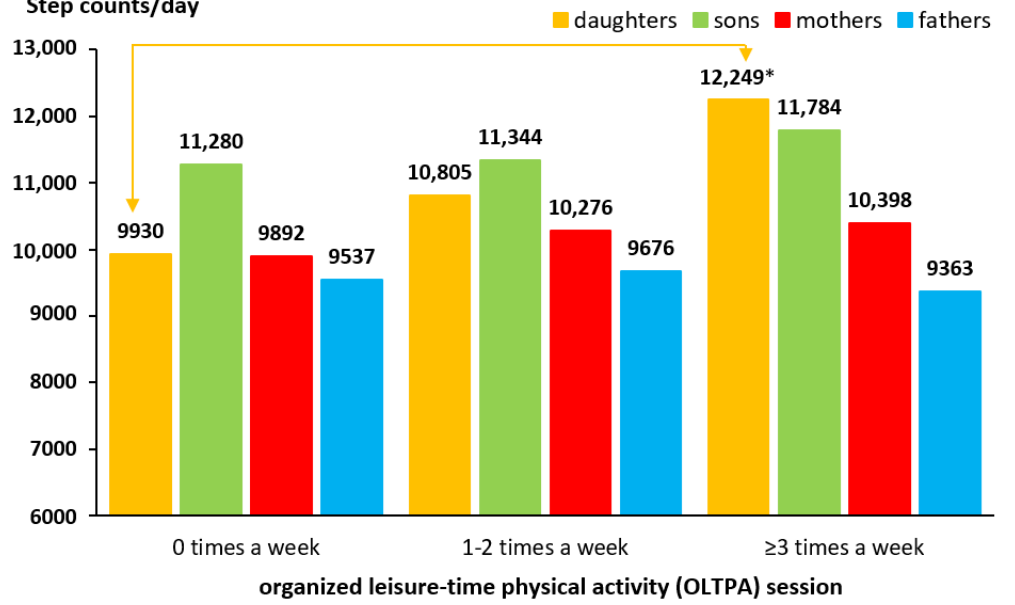
Figure 1. The median of daily step counts of family members separated according to the frequency of organized leisure-time physical activity of the o ff spring (* statistically significant di ff erences between participation 0 and ≥ 3 times a week in OLTPA based on the Mann-Whitney U test, p < 0.001